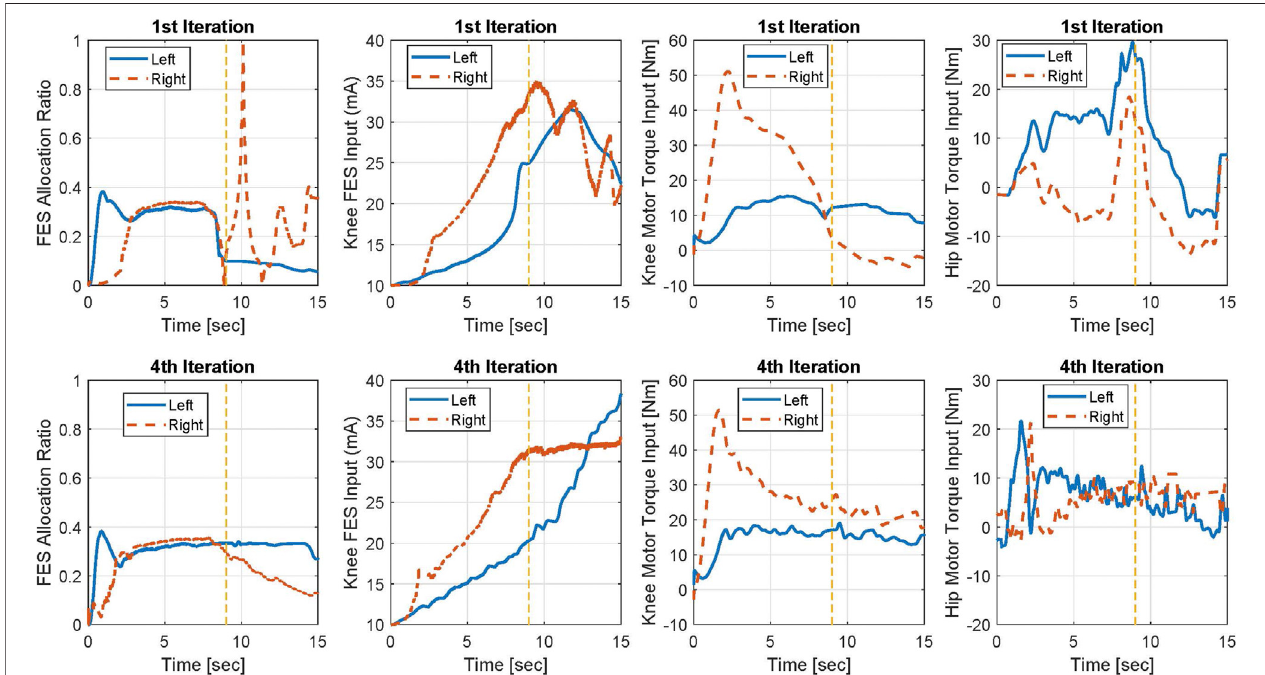
FIGURE7| Bottom-levelcontrolinputsforParticipant2allocatedbyMPCinthe1stand4thiterations.Yellowdashedlineshowstheapproximatetimeinwhichthe sit-to-stand movement is mainly done.